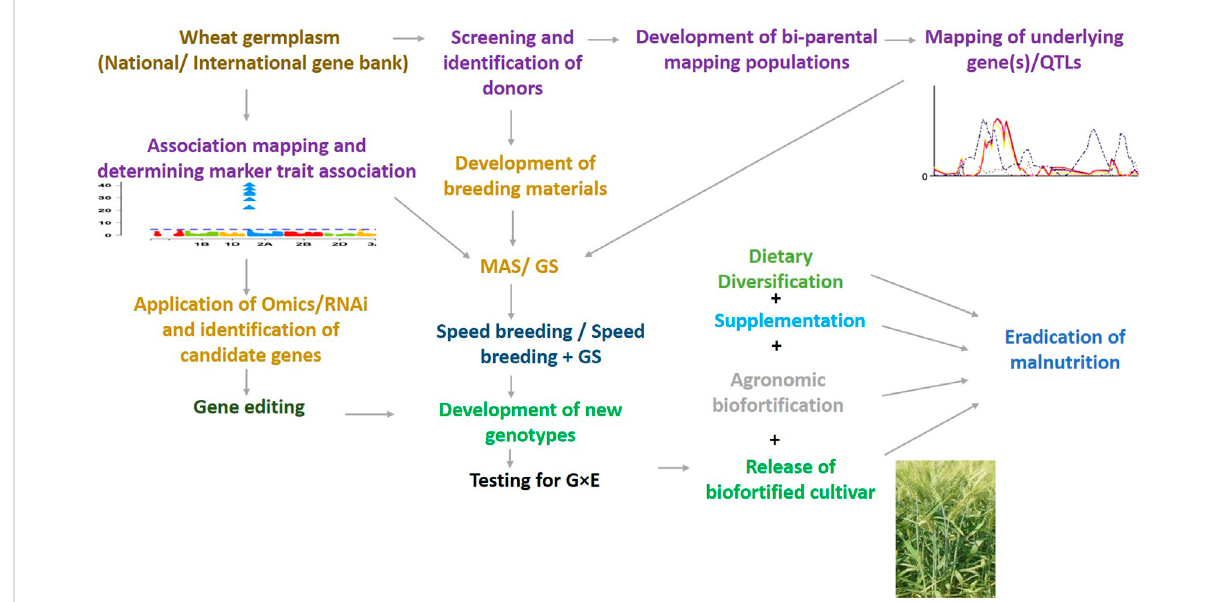
FIGURE 1 An integrated approach for eradication of malnutrition including new breeding techniques, supplementation and diversi fi